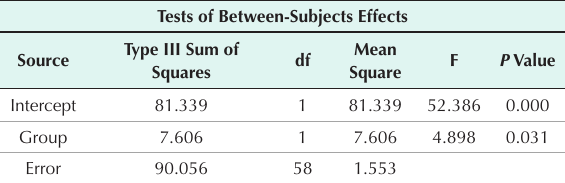
Table 4. The Results of ANOVA With Repeated-Measures of the Severity of Diaper Dermatitis in the Intervention and Control Groups Tests of Between-Subjects